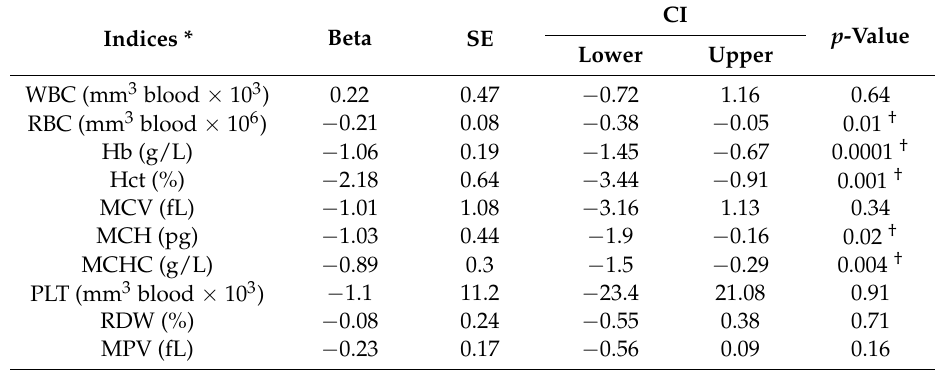
Table 4. Association between exposure to anesthetic gases and changes in the complete blood count (CBC) parameters using the linear regression